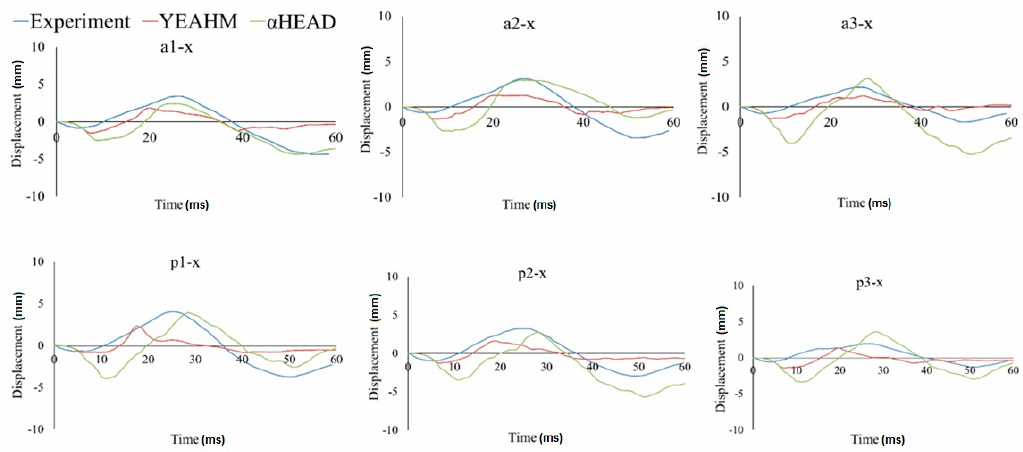
Figure 6. Comparison of the displacement-in-time characteristics of the markers in the frontal (a) and rear columns (p) in the X-direction for the C755-T2 test, and α HEAD and YEAHM numerical models.